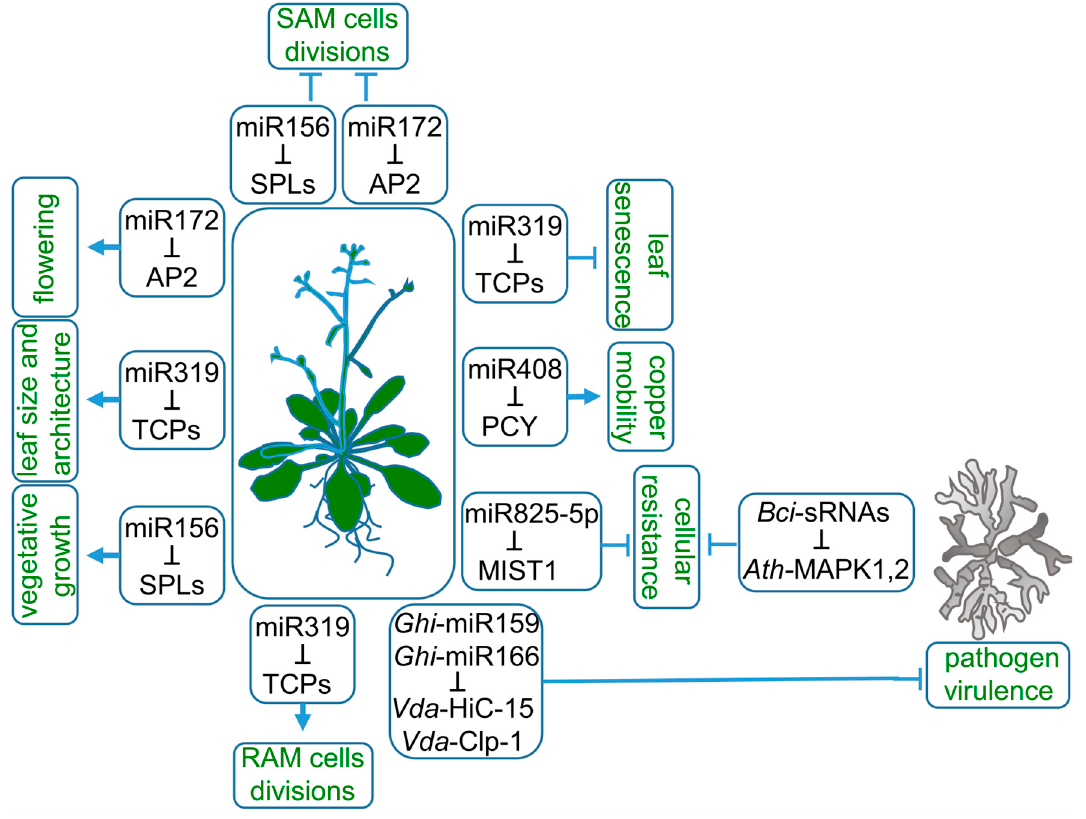
Figure 1. Roles of miRNAs in plant life. MiRNA156, miRNA172 and miRNA319 target SQUAMOSA promoter-binding protein-like (SPLs), APETALA2 (AP2) and TEOSINTE BRANCHED/CYCLOI- DEA/PROLIFERATING CELL FACTOR1 (TCPs) mRNAs, respectively, to regulate a wide range of plant characteristics, such as the length of vegetative growth, flowering time, root and leaf architec- ture. Copper mobility is controlled by miRNA408-targeting mRNA of the copper-sequestrating pro- tein—plantacyanin (PCY). Plant resistance to pathogens is modulated at the cellular level by down- regulation of microrna-silenced toll/interleukin-1 domain ( MIST1 ) transcript by miRNA825-5p. The ex- port of miRNA159 and miRNA166 to pathogen tissues downregulates fungal proteins essential for